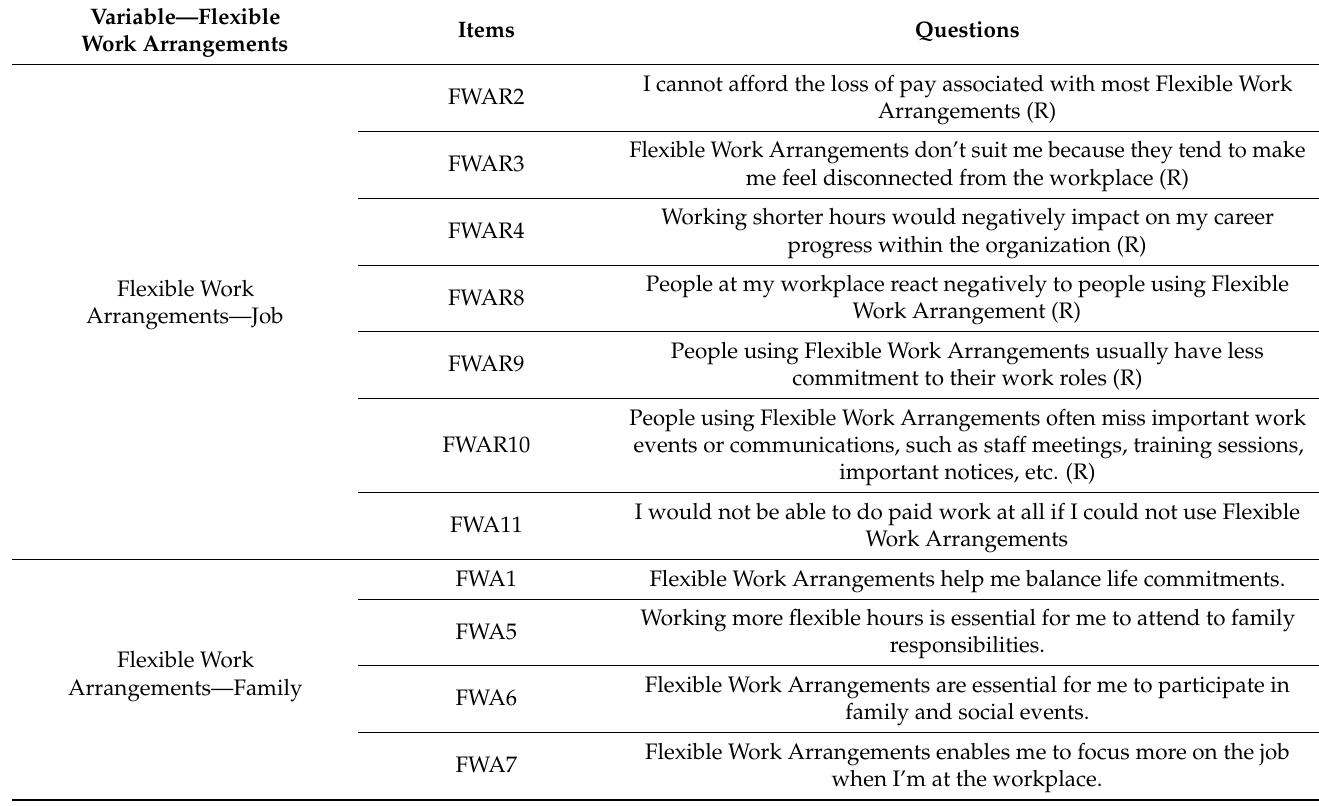
Table 1. Questions about the independent variable—Flexible Work Arrangements (2nd part).